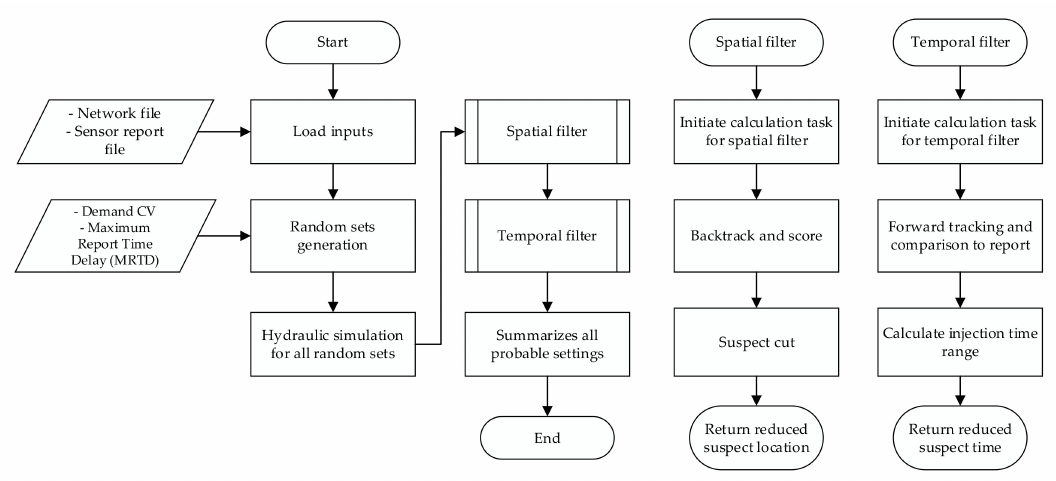
Figure 1. Contamination-probable setting identifier (CPSITE) calculation